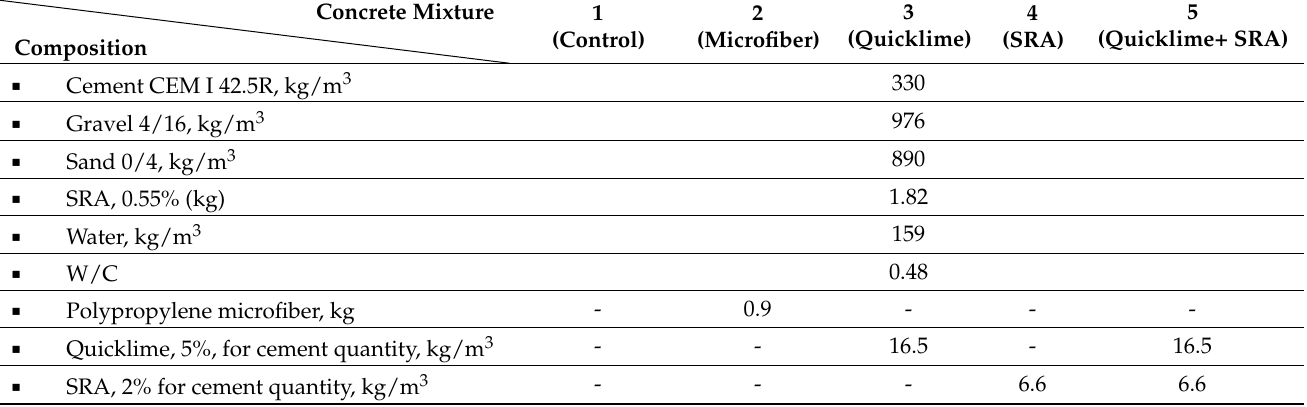
Table 1. Concrete compositions capable of dealing with shrinkage.